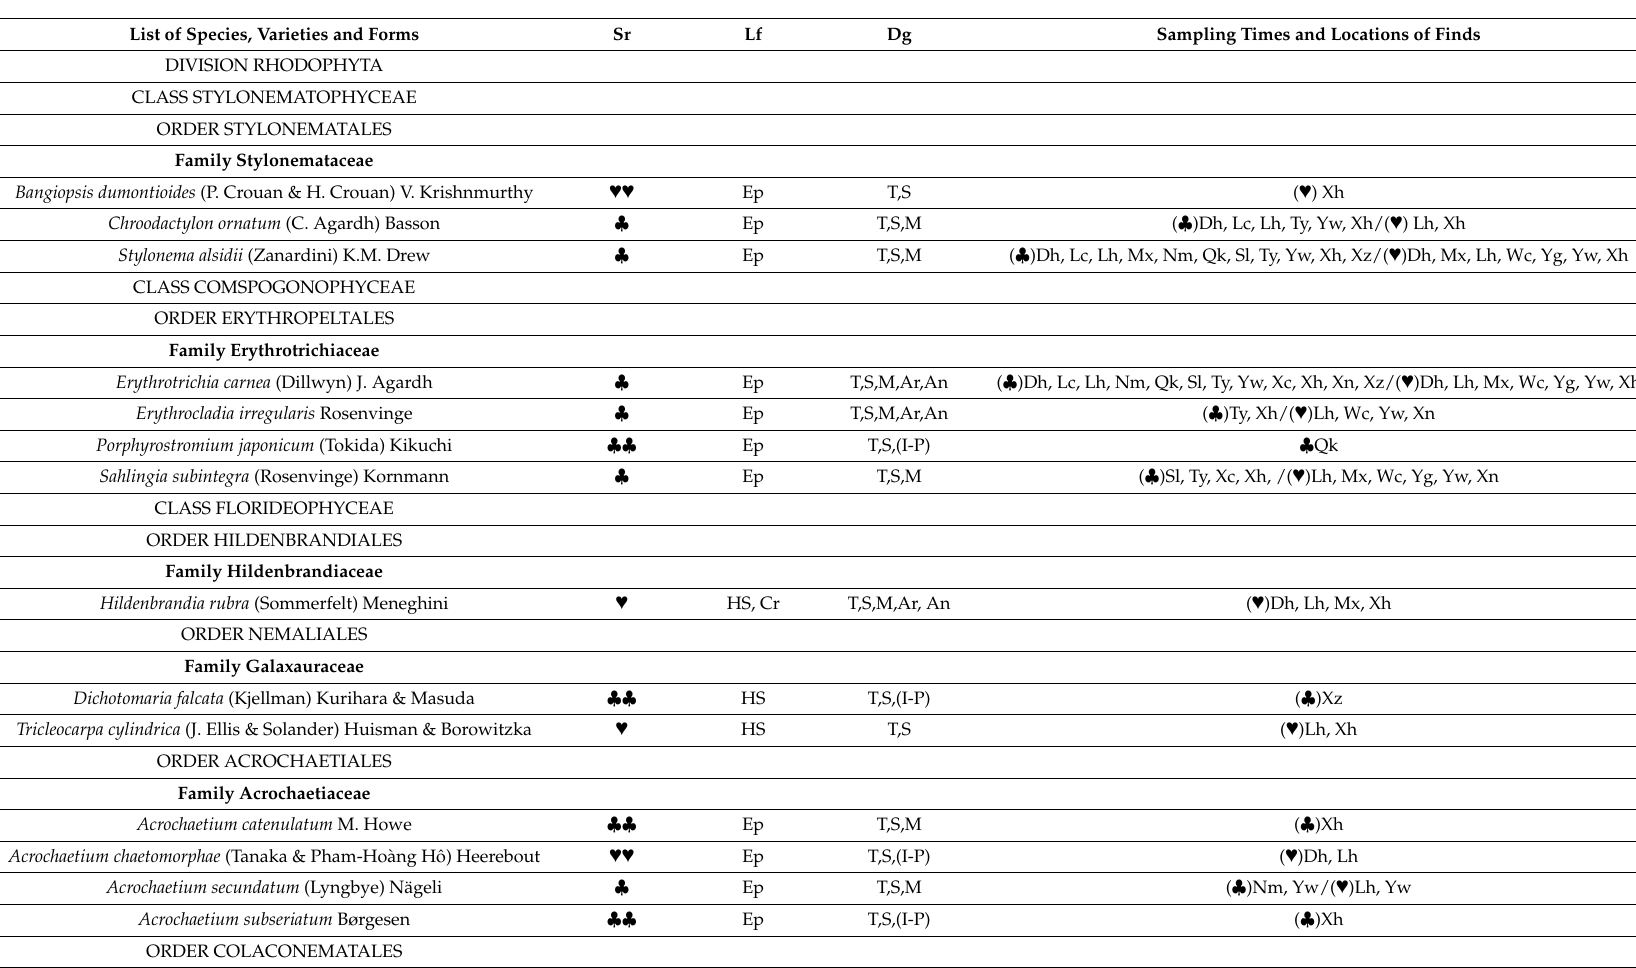
Table 1. Annotated list of new records of benthic red algae (Rhodophyta) recorded from the shores of Hainan Island between 1990 and 2016. List of Species, Varieties and Forms Sr Lf Dg Sampling Times and Locations of